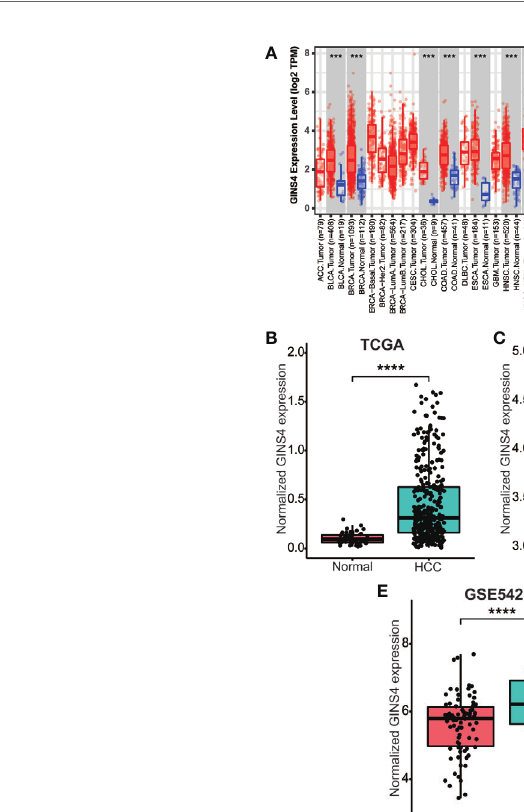
Table 1 demonstrated the correlation between GINS4 mRNA levels and clinicopathologic parameters of 371 HCC patients